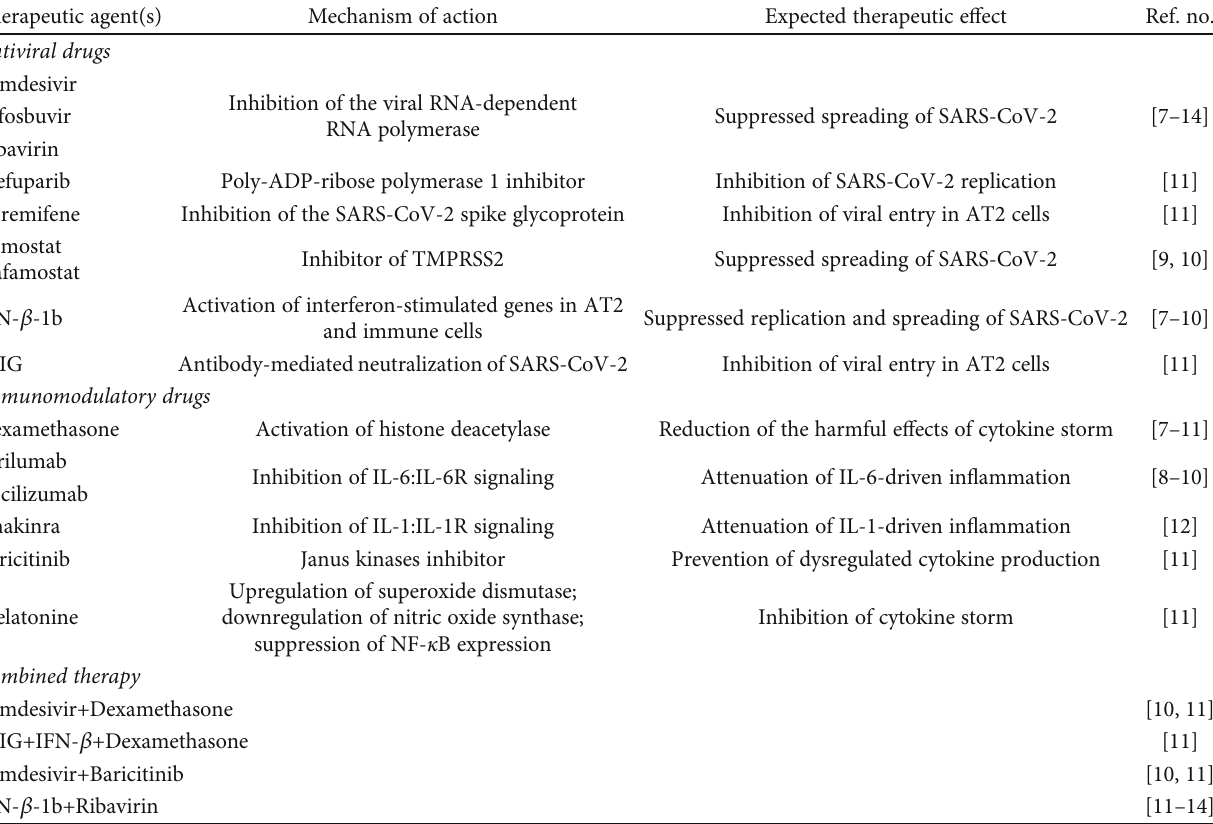
Table 1: The list of the drugs which are tested as therapeutic agents for the treatment of COVID-19. Therapeutic